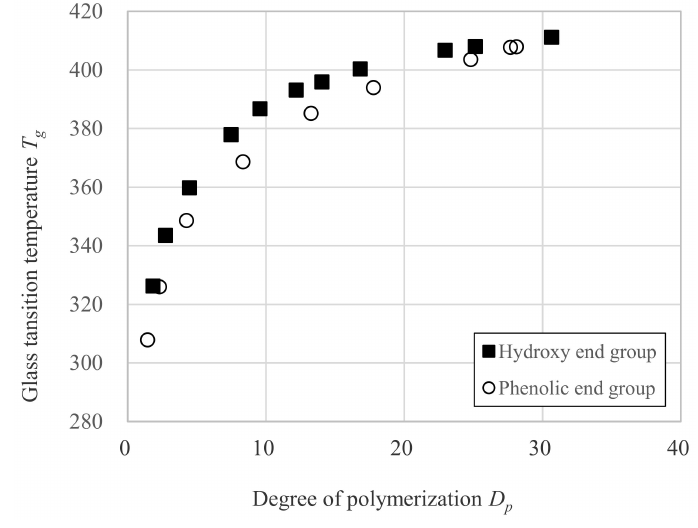
Figure 9. Relation between D p and T g.